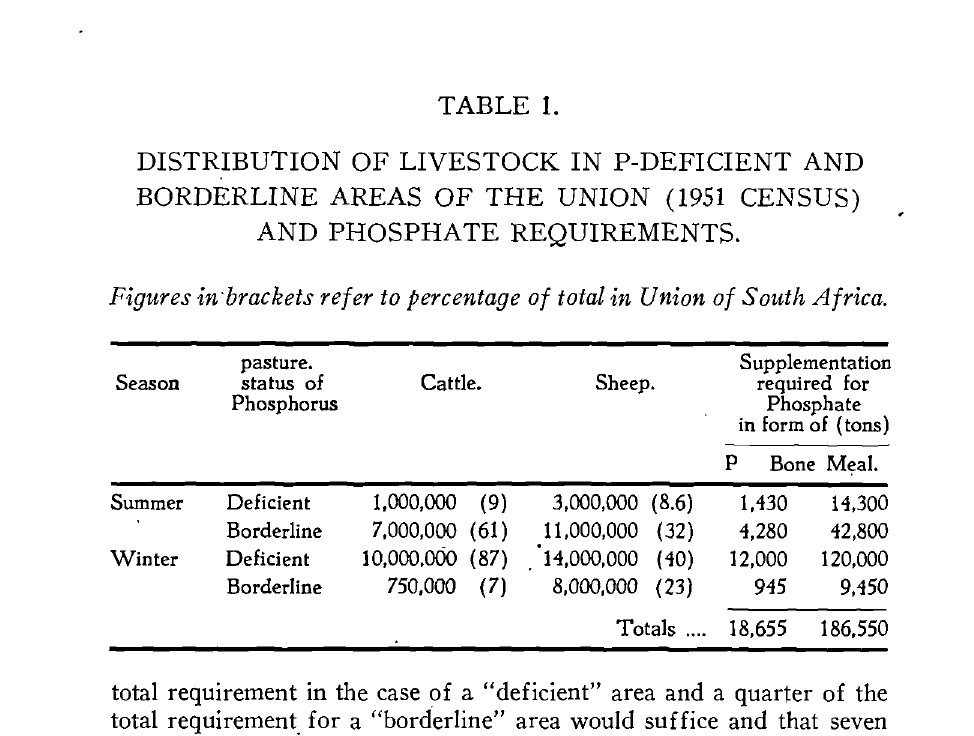
DISTRIBUTION OF LIVESTOCK IN P-DEFICIENT AND BORDERLINE AREAS OF THE UNION (1951 CENSUS) AND PHOSPHATE